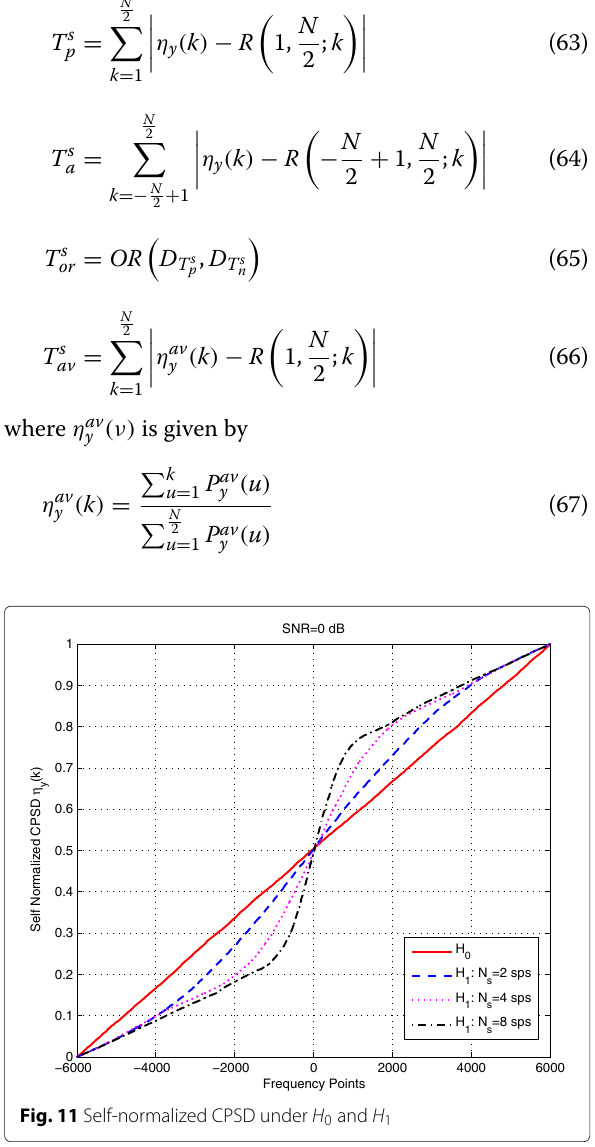
noise uncertainty than the energy detector for p fa = 0.1.